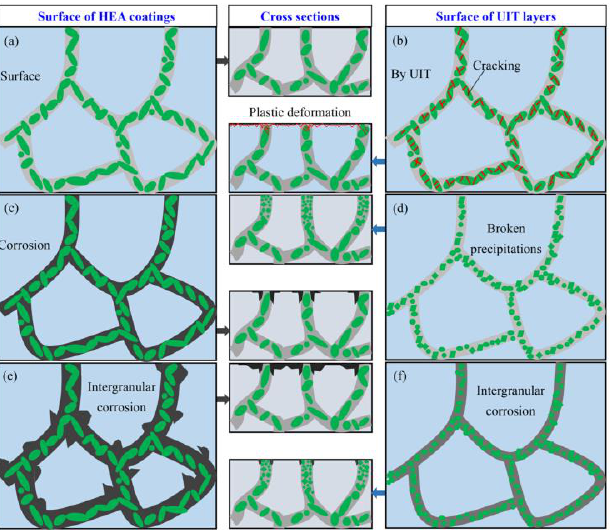
Figure 3. Diagrammatic comparison of the UIT layers and HEA coatings. ( a ) Surface of HEA coatings; ( b ) surface of UIT layers; ( c ) HEA coating is corroded; ( d ) fractured precipitations and narrower grain boundaries; ( e ) substantial intergranular corrosion of HEA coatings; ( f ) mild intergranular corrosion of UIT layers. Reprinted with permission from [21] 2021 Elsevier.